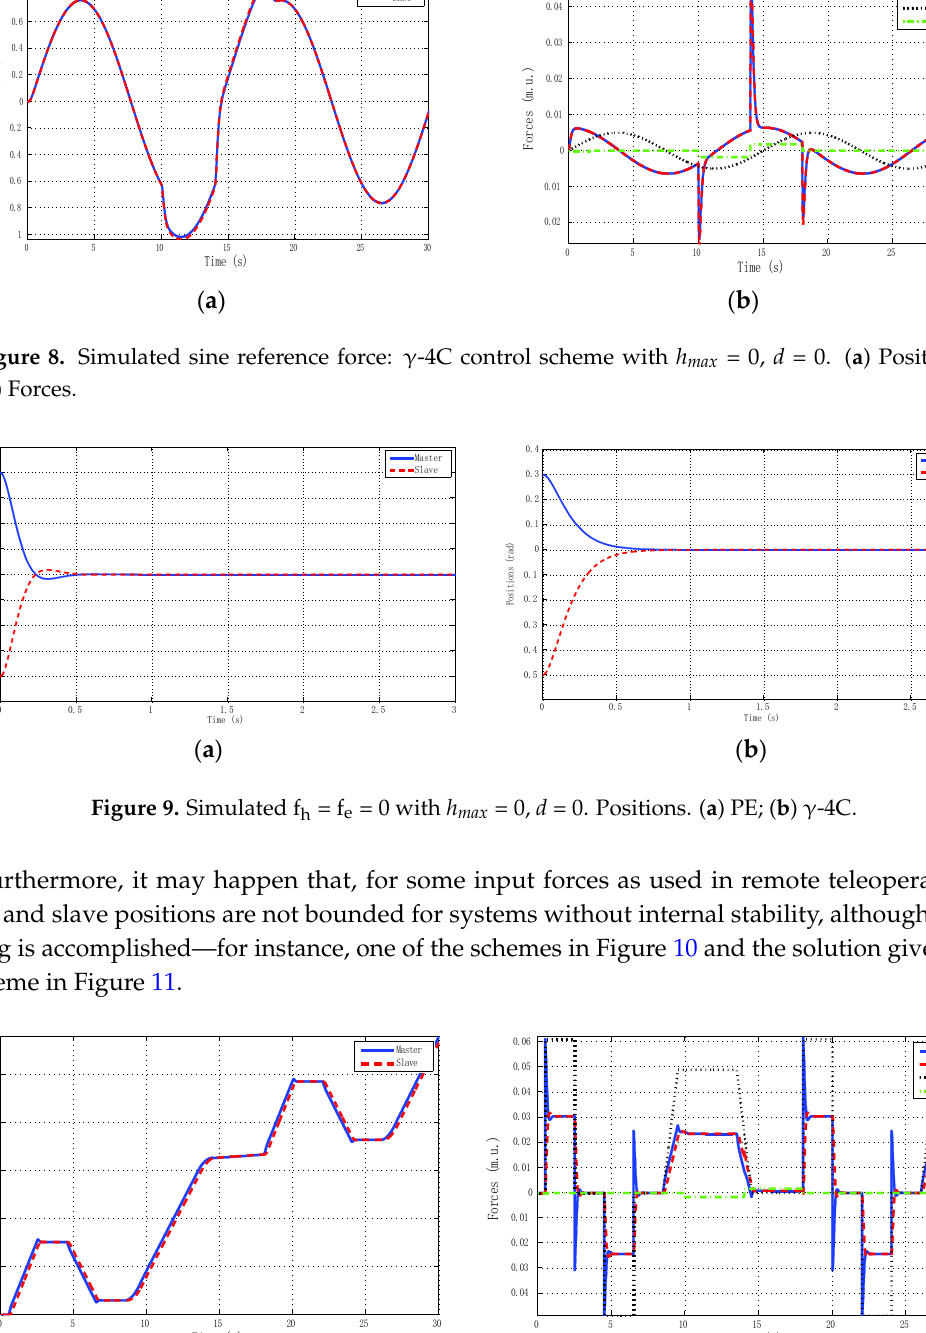
Figure 8. Simulated sine reference force: γ-4C control scheme with h max = 0, d = 0. ( a ) Positions; ( b ) Forces.